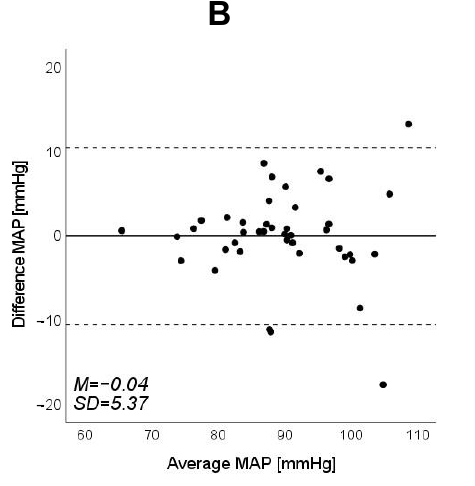
Figure 10. Bland–Altman plots of estimated diastolic blood pressure (DBP) against those measured with a cuff sphygmomanometer ( N = 42). From left to right, the light source is blue (B), green (G), red (R), and near-infrared (NIR). The solid line and the dashed lines on each plot represent fixed bias (M) and M ± 1.96 standard deviation range, respectively.